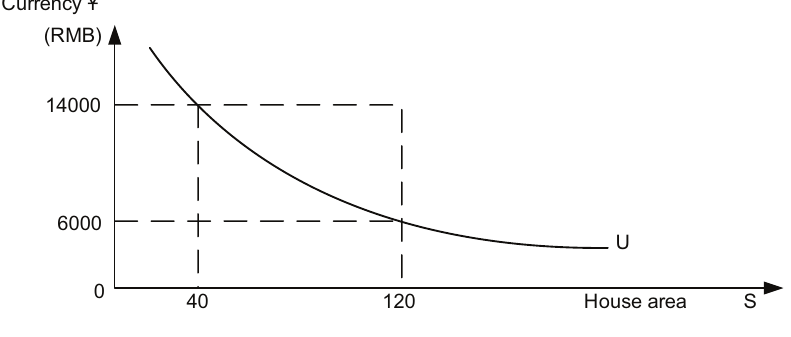
figure 4. Indifference curve of currency and house area